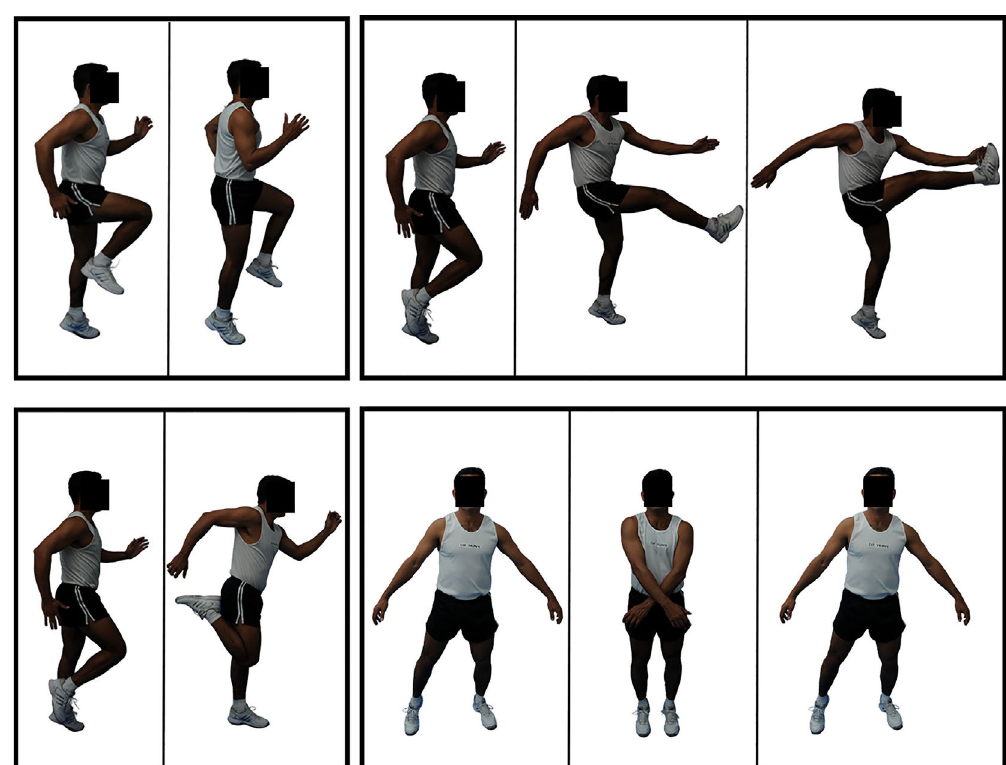
Figure 2 - Localized-effect exercise protocol. Source: Brazil (2015).